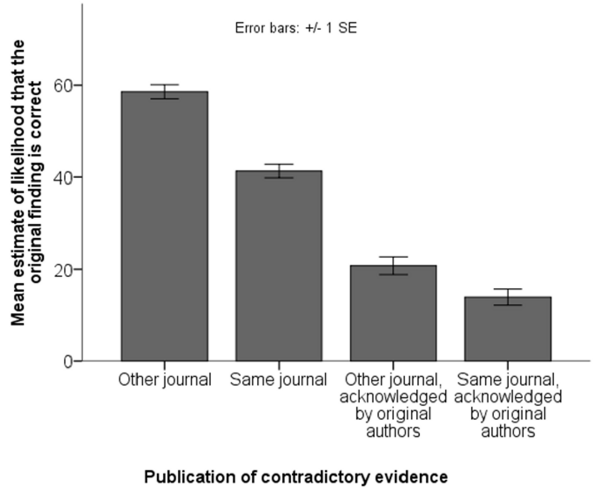
Figure 2. Results from Study 2.